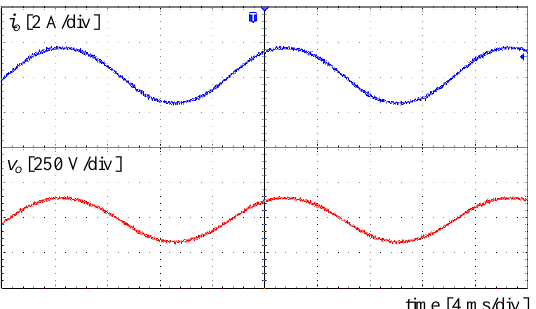
Figure 11. Experimental waveforms: current and voltage waveforms of the output.